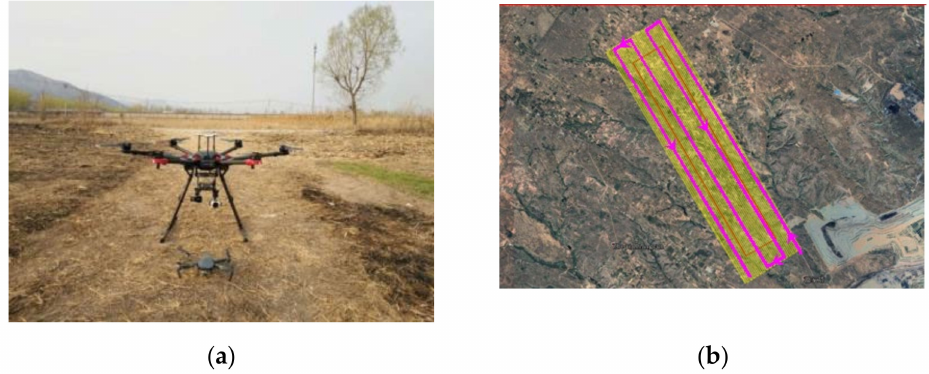
Figure 9. Photos and flight path of UAV on site: ( a ) UAV photo; ( b ) Flight